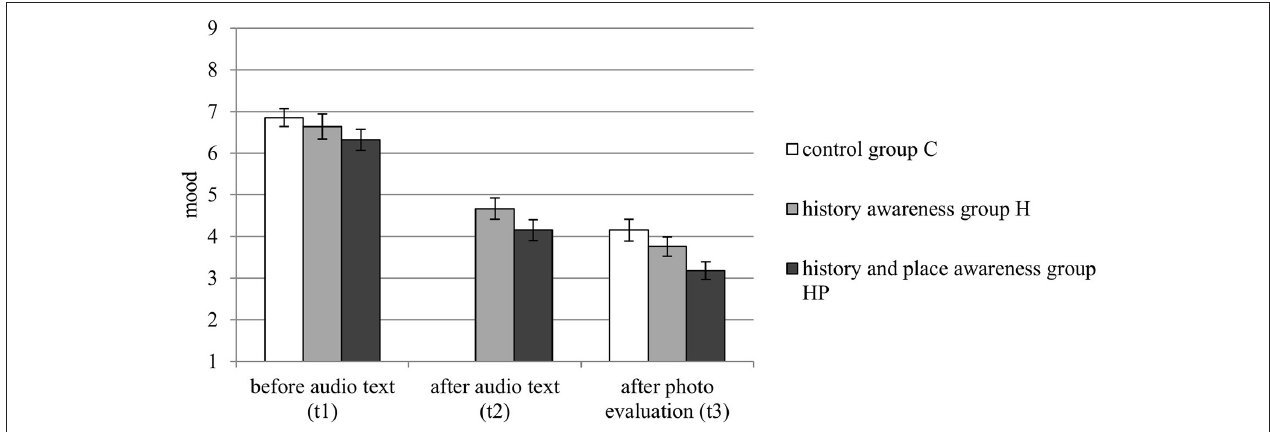
FIGURE 2 | Participants’ personal mood and arousal at three different times (t1, t2, t3) by condition. Lower scores indicate a more negative mood. Error bars represent standard error of mean.